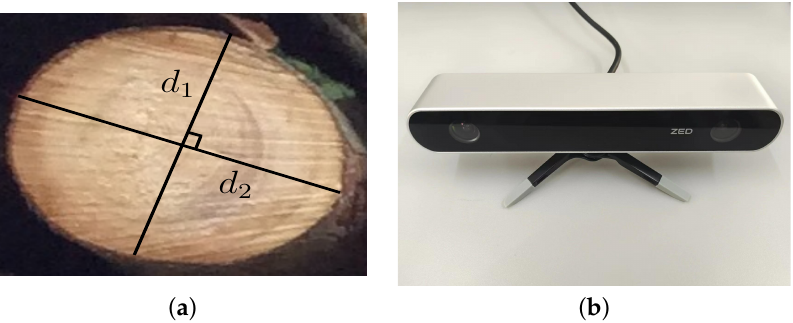
Figure 3. ( a ). Long and short diameter measurement schematic, d 1 is the short diameter, and d 2 is the long diameter. ( b ). ZED camera.